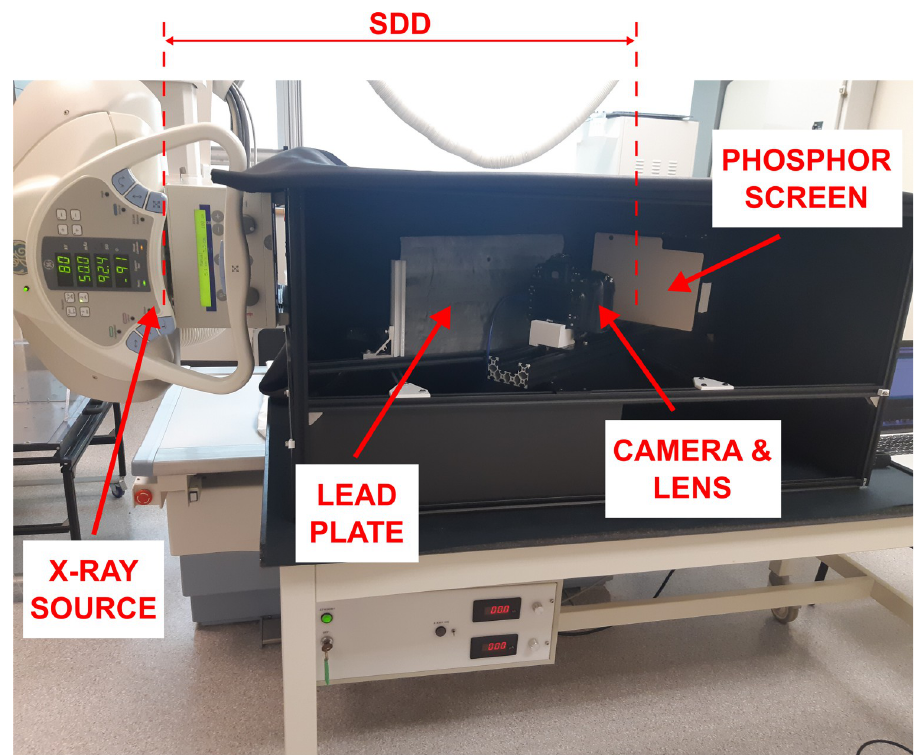
Fig 2. Experimental setup using the general-purpose x-ray source. Note that the rotary stage is not visible as it is hidden behind the lead plate. The source-to-detector distance (SDD) was 600 mm.